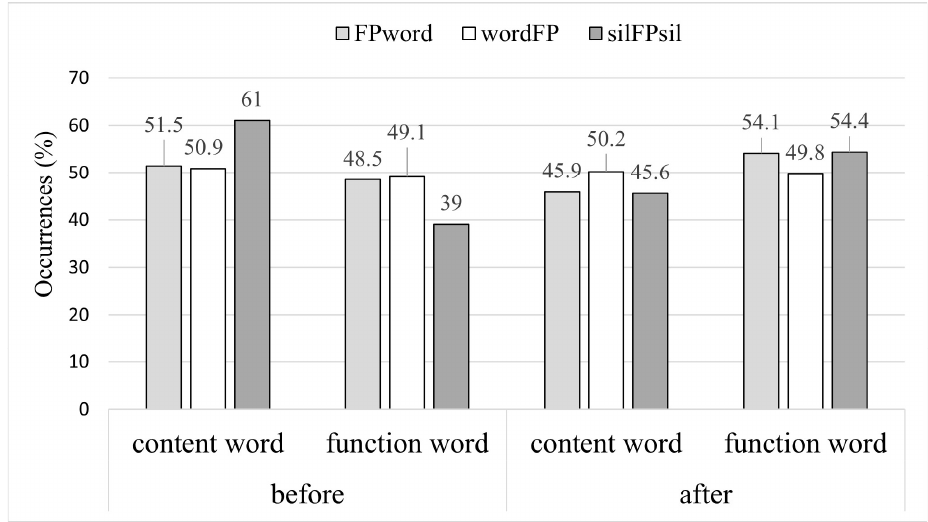
Figure 2. Incidence of content and function words according to FP positions.